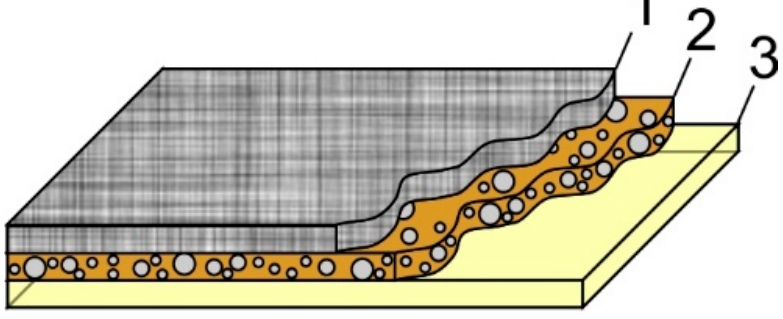
Figure 9. Principle structure of the proposed bandage: ( 1 ) synthetic silk substrate; ( 2 ) thin nanocomposite DLC:Ag films etched for 20 s in O 2 plasma; ( 3 ) protective layer made from the cellulose sheet (membrane) and the gelatin layer.